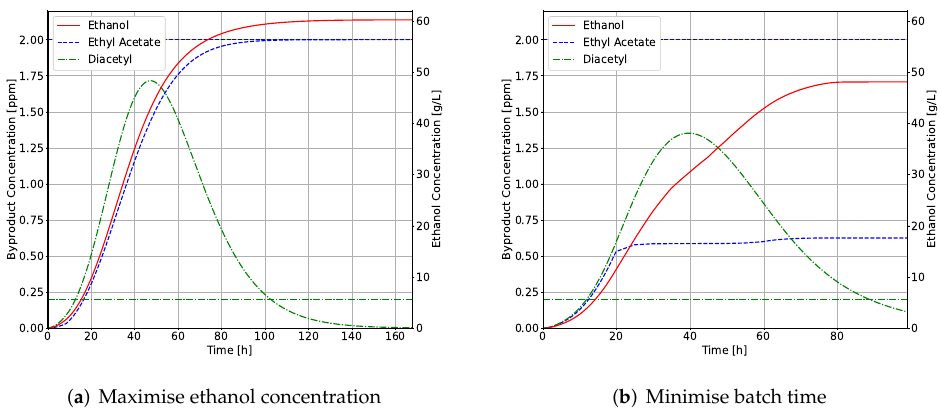
Figure 2. Concentration profiles of ethanol and the two byproducts for the nominal case with two different objectives: maximising ethanol concentration and minimising batch time. The byproducts are represented on the left y-axis and ethanol on the right y-axis. The horizontal lines depict the constraints on the